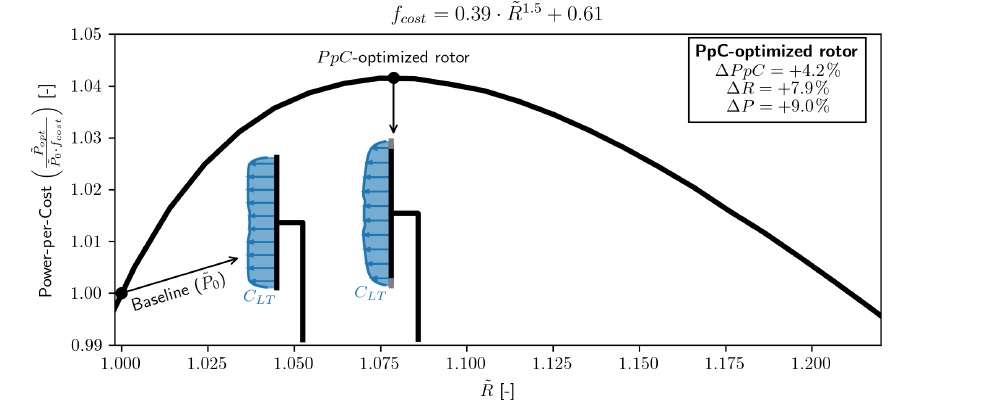
Figure 7. Relative power per cost (PpC) vs. radius ( ˜ R ). The cost-optimized rotor is found to have a (cid:49)R = + 7 . 9% increase in rotor radius, leading to a (cid:49) PpC = + 4 . 2%